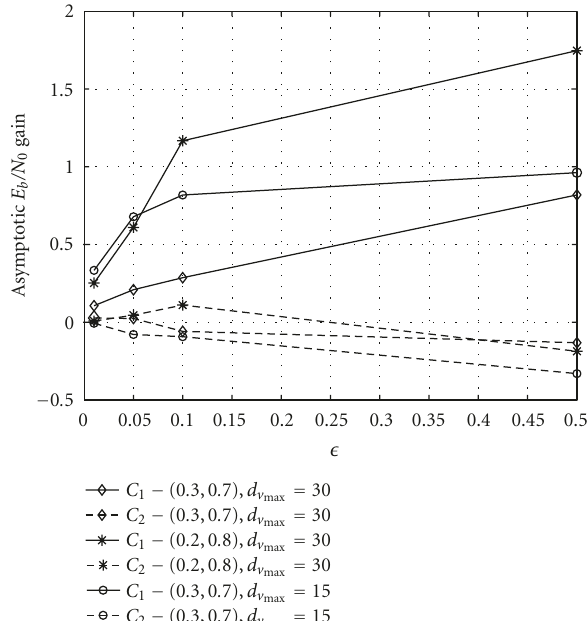
Figure 2: E b /N 0 gain for information classe C 1 and C 2 . The E b /N 0 gain is obtained for BER = 10 − 5 .